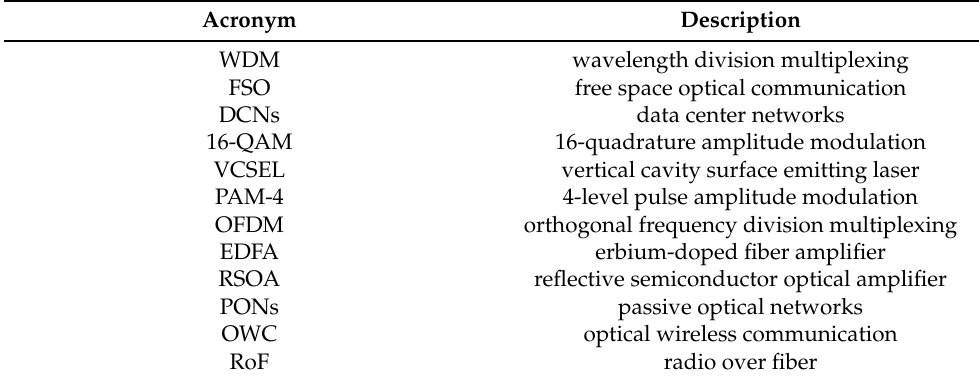
Table 1. List of